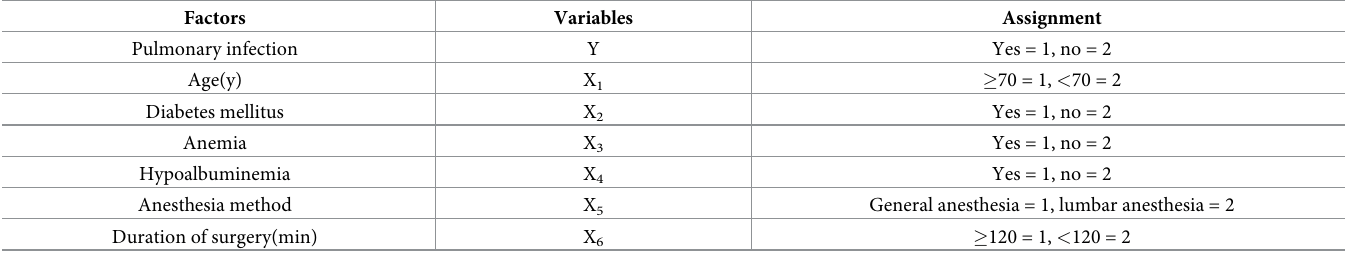
Table 2. The variable assignments of multivariate logistic regression.